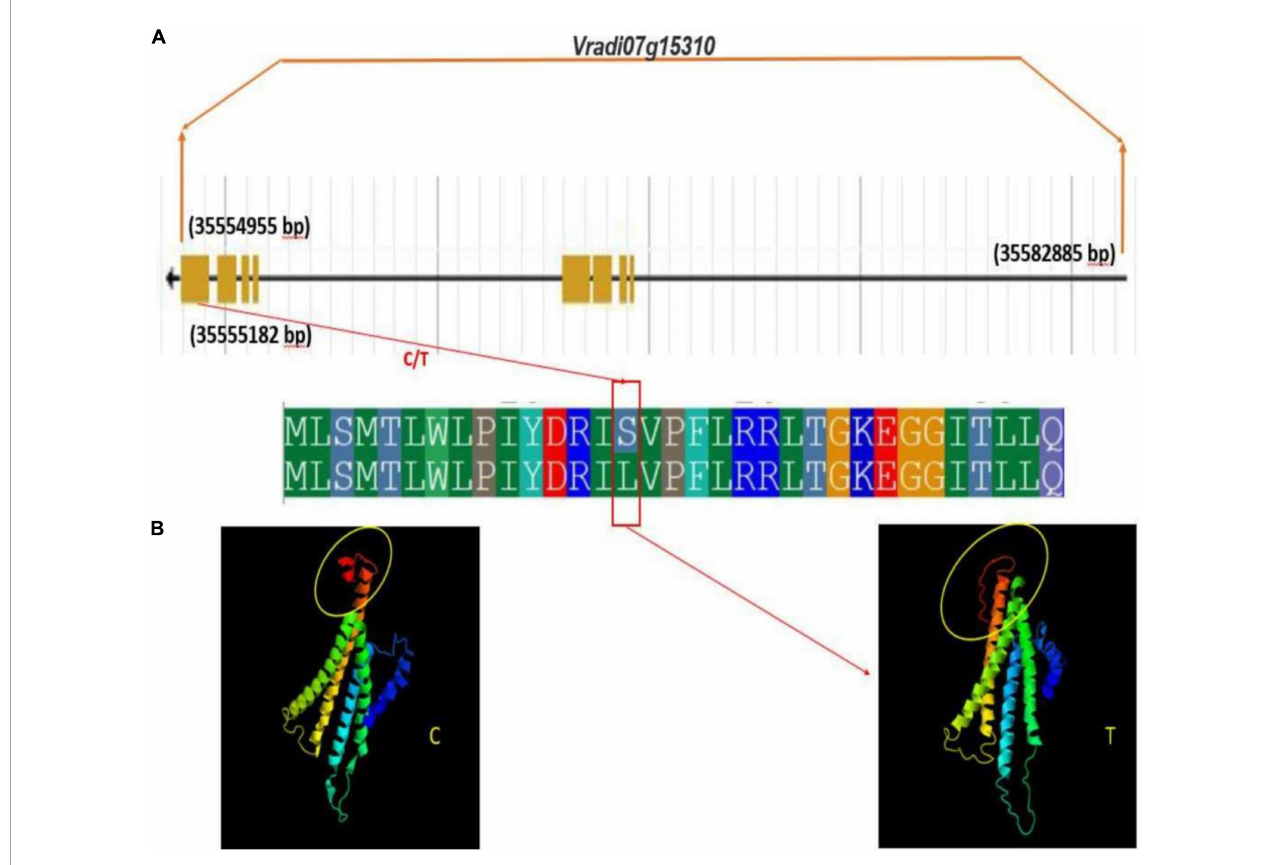
FIGURE10 Gene and protein structure of potential candidate gene Vradi07g15310 (A) gene structure (B) conformational changes in protein structure due to sense SNP (C/T) at the CDS domain.